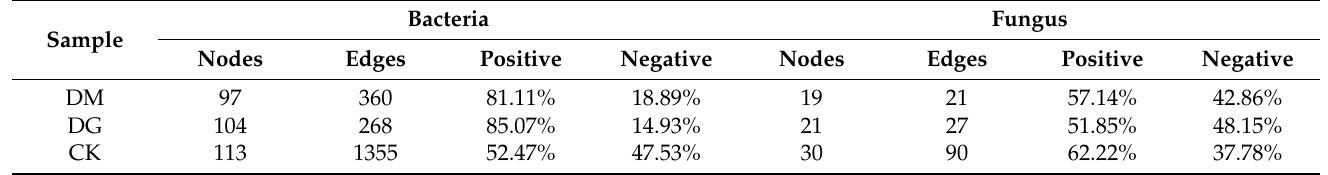
Table 2. Analysis of the bacterial and fungal populations’ network of